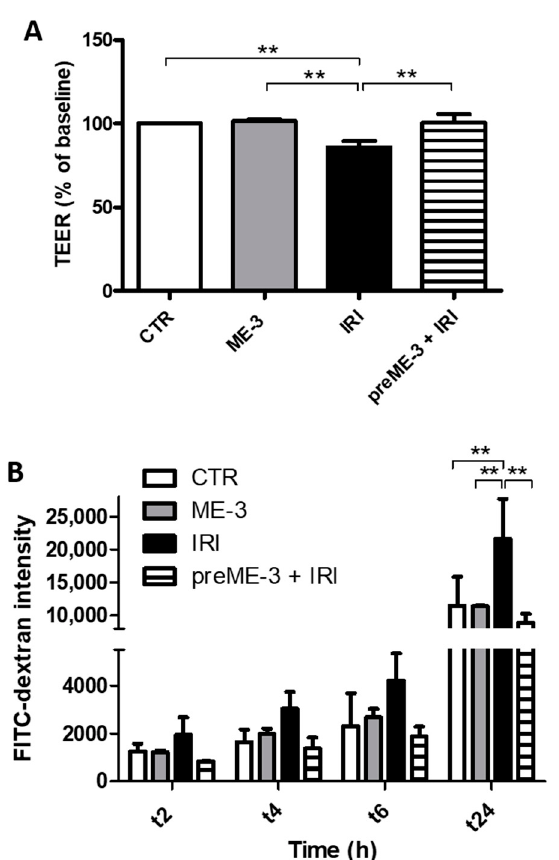
Figure 2. Effect of ME-3 ® on the permeability of Caco-2 monolayers subjected to Irinotecan treatment. Permeability evaluated in Caco-2 monolayer cells treated for 24 h with ME-3 ® (10 7 CFU/mL) and IRI (155 µ g/mL) alone or in combination (preME-3 ® + IRI). ( A ) TEER values were expressed as TEER % of baseline (untreated control), quantified by measuring the differences between the TEER values at 24 h; values were expressed as means ± SDs. ( B ) Time course of dextran flux across Caco-2 monolayer cells. (FITC)-4kDa dextran was added to the apical chamber, and the fluorescence intensity of the medium in the basolateral chamber was measured at different time points after treatment. Three independent transwells were tested for each condition, and values were expressed as means ± SDs. Asterisks represent significant differences between indicated groups: ** p <